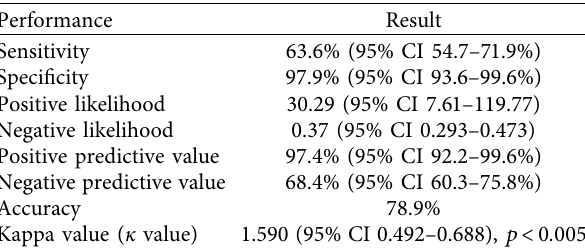
Figure 1: Age distribution of RT-PCR positive cases by gender, demonstrating high SARS-CoV-2 infection among both male and female subjects of age range 20–29 years followed by the age group ranging 30–39 years. Table 4: Overall diagnostic performance evaluation of rapid an- tigen test.